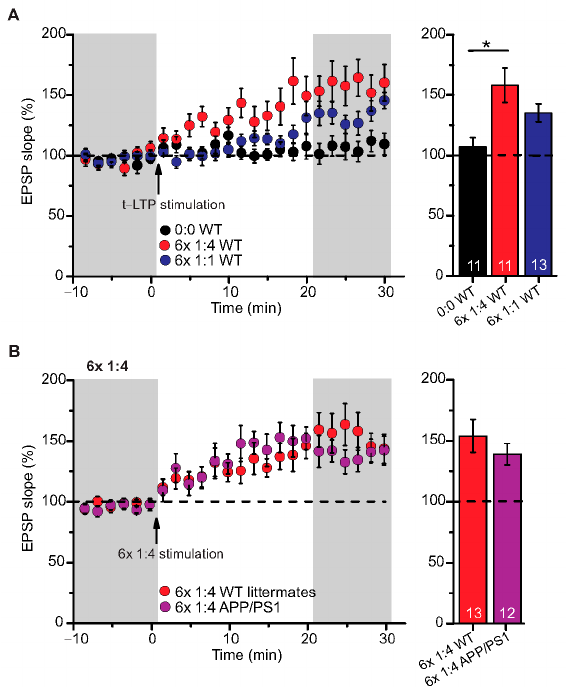
Figure 2. Intact t-LTP in adult APP/PS1 mice induced by 6 × 1:4 STDP paradigm. Whole cell patch clamp recording of t-LTP in acute hippocampal slices from 6-month-old wild type and APP/PS1 mice using the STDP paradigms described in Figure 1. Left: Mean time-course of EPSP slopes with either of the two different STDP paradigms (indicated by arrows). Right: Averaged change in EPSP slopes 21–30 min following t-LTP induction normalized to control before t-LTP induction. ( A ) WT mice expressed significant t-LTP induced by 6 × 1:4 stimulation (red circles, n = 11/N = 8; p = 0.003), while the 6× 1:1 stimulation induced synaptic change did not yield statistically significant t-LTP (blue circles, n = 13/N = 10; p = 0.104) compared to unpaired control (black circles, n = 11/N = 10). ( B ) Hippocampal SC-CA1 synapses in APP/PS1 animals showed unaltered t-LTP (purple circles, n = 12/N = 6; p = 0.354), induced by 6× 1:4 stimulation, compared to WT littermate mice (red circles, n = 13/N = 7). Data shown as mean ± SEM. Digits in the bars represent the number of recorded neurons per condition. *: p < 0.05, multiple comparisons were performed with ANOVA followed by post hoc Dunnett’s test ( A ) and non-parametric data were compared with Mann–Whitney U-test ( B ).